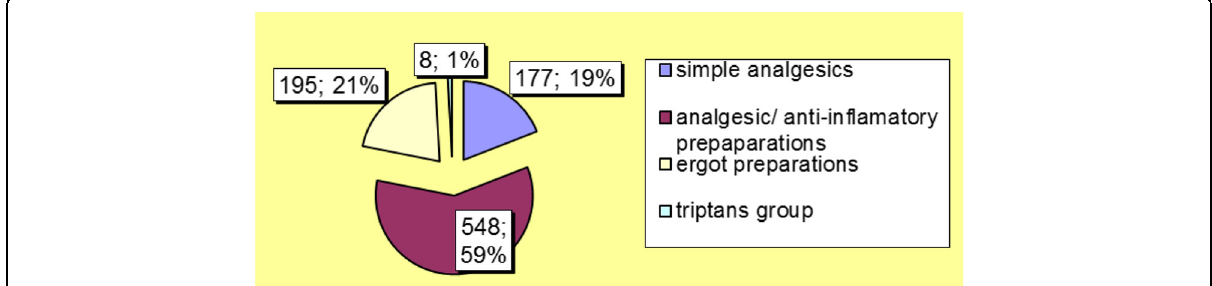
Fig. 3 Drug options used among studied migrainous